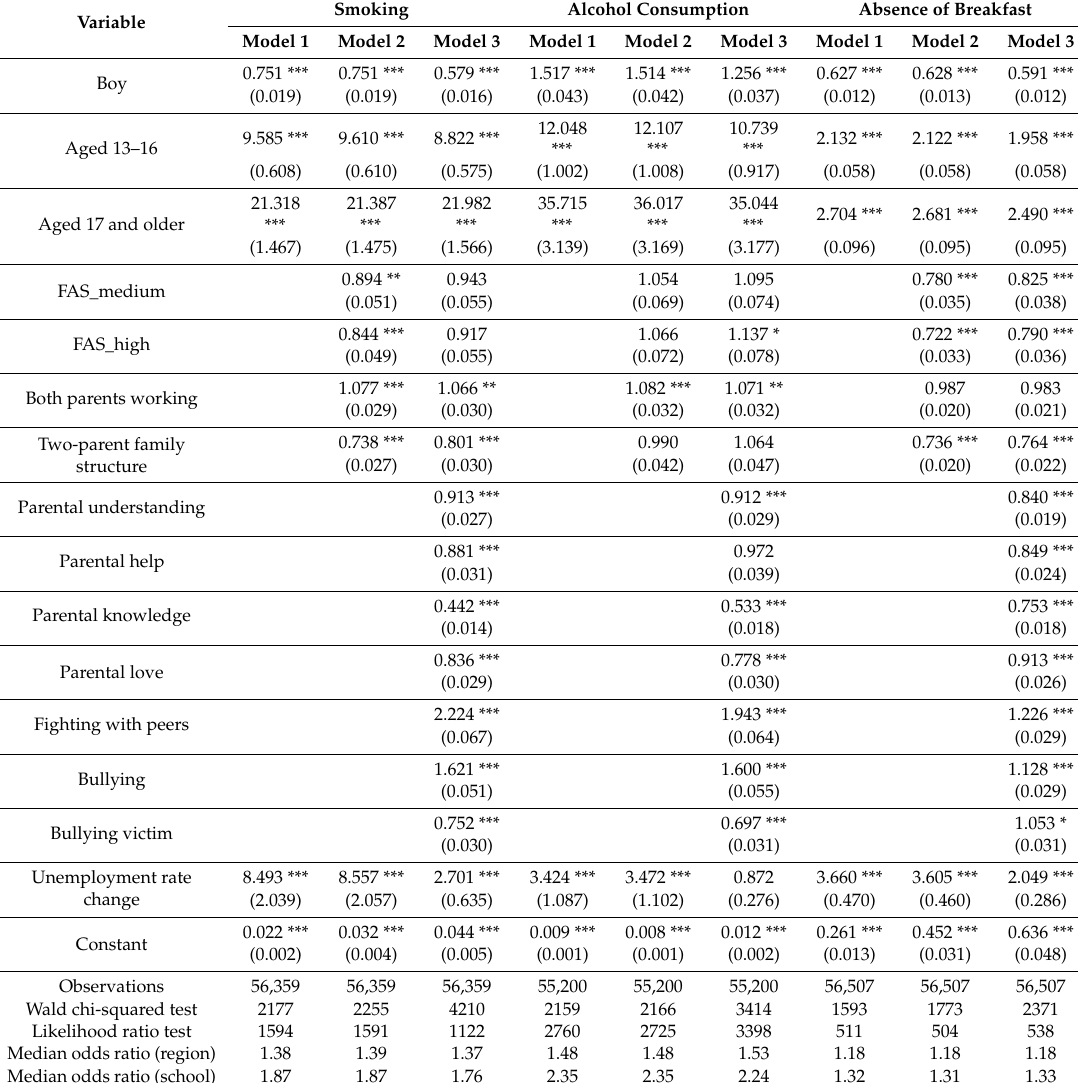
Table 5. Results from the multilevel logistic regressions on lifestyle habits (odds